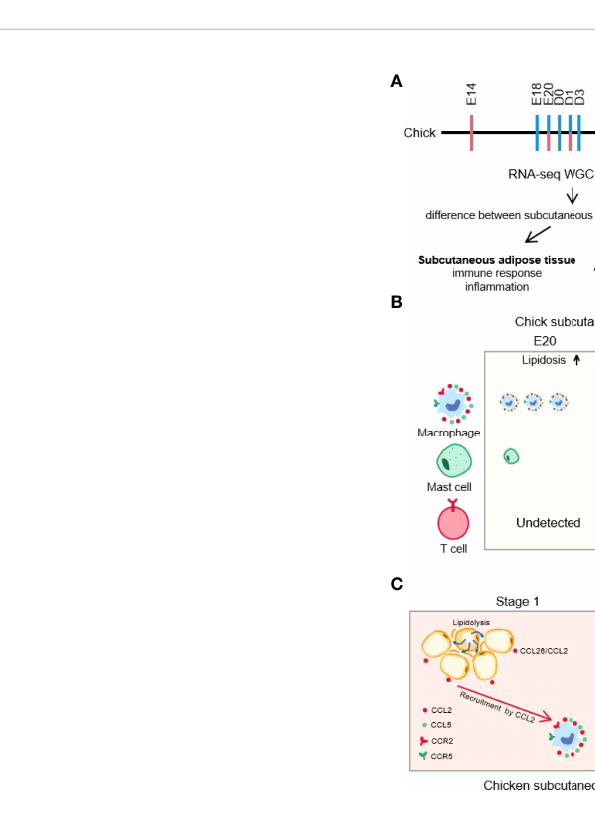
FIGURE 15 | Graphical abstract. (A) Transcriptome sequencing and analysis protocol of chick subcutaneous and abdominal adipose during the embryonic and post-hatch period; (B) immune in fi ltration of chick subcutaneous adipose tissue between E20 and D1; (C) FFA-induced Ccl2 (Chicken CCL26 ) secretion is crucial in determining fat depot-selective adipose tissue macrophage (ATM) in fi